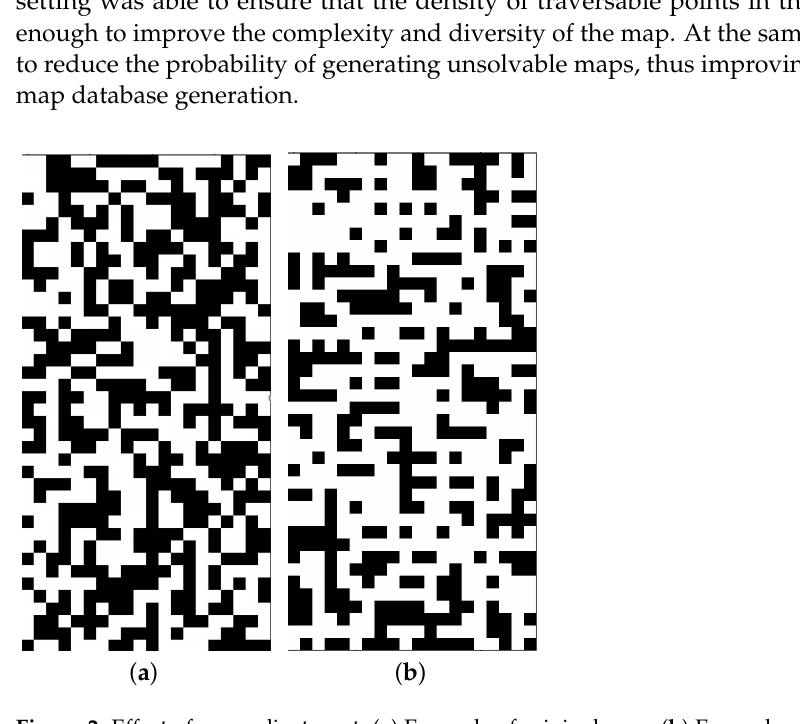
Figure 2. Effect of map adjustment. ( a ) Example of original map; ( b ) Example of adjusted